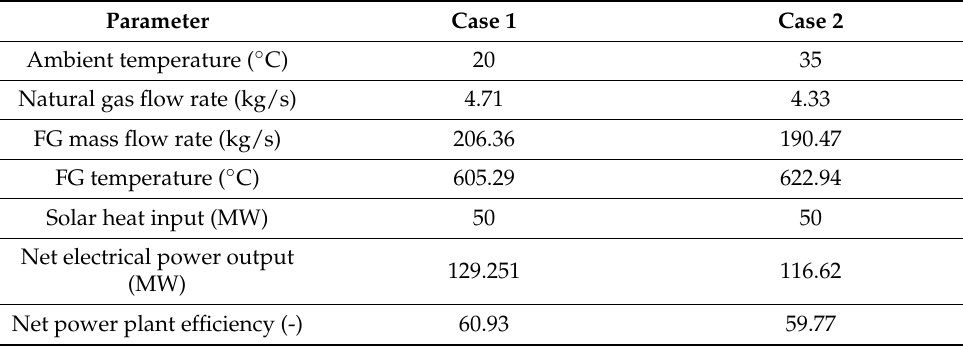
Table 5. Reference steady-state cases description (operational design